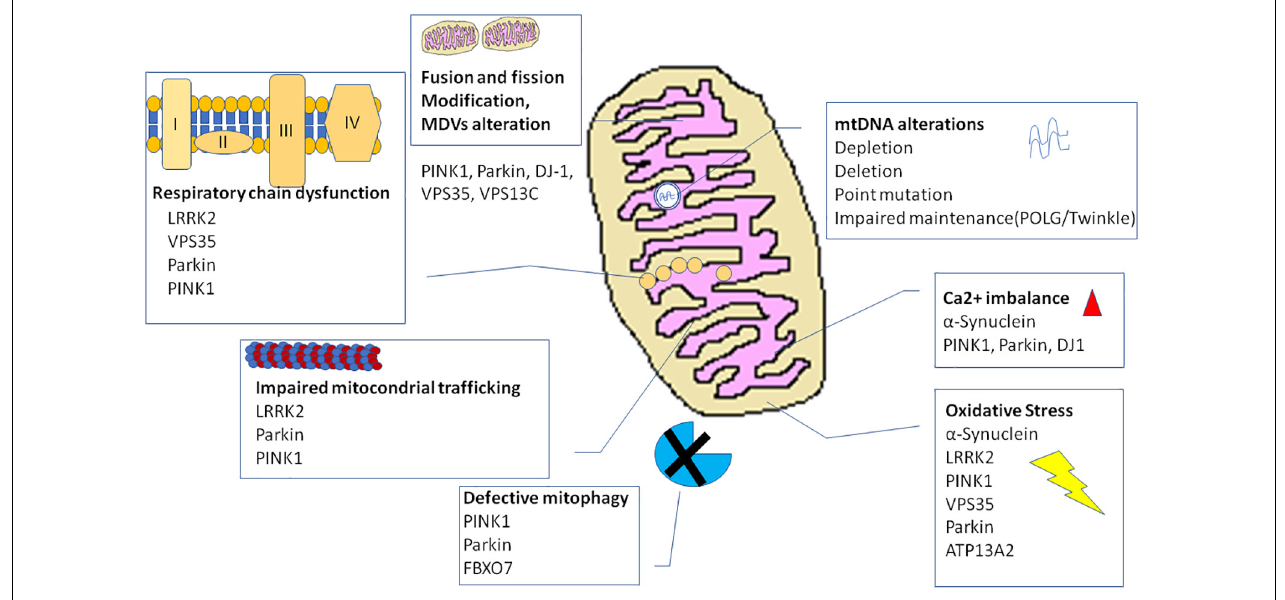
FIGURE 2 | Mechanisms and genes involved in mitochondrial dysfunction in Parkinson’s disease. ATP13A2, ATPase cation transporting 13A2; DJ-1, protein deglycase; LRRK2, leucine-rich repeat kinase 2; PINK1 , phosphatase and tensin homolog (PTEN)-induced putative kinase 1; VPS35, vacuolar protein sorting 35.